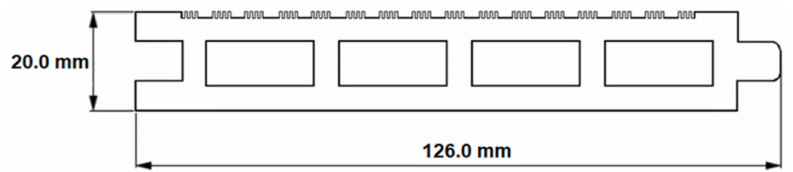
Figure 1. Schematic of the hollow-shape decking board